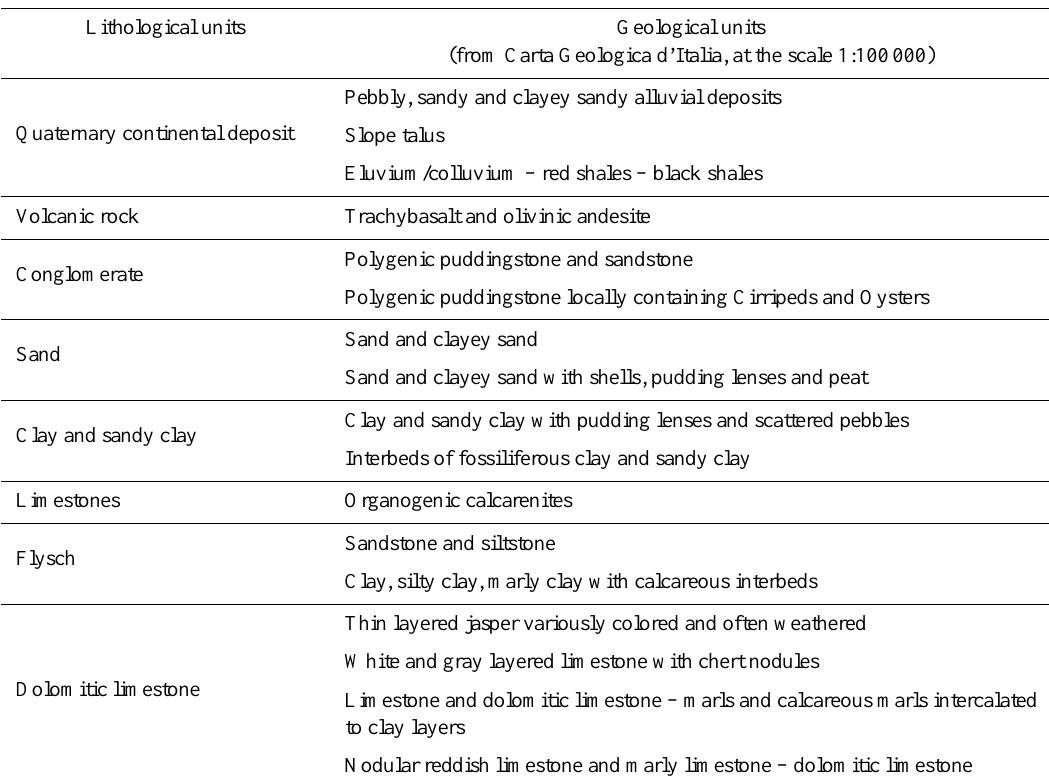
Table 2. Classification of Geological Units in Lithological classes.